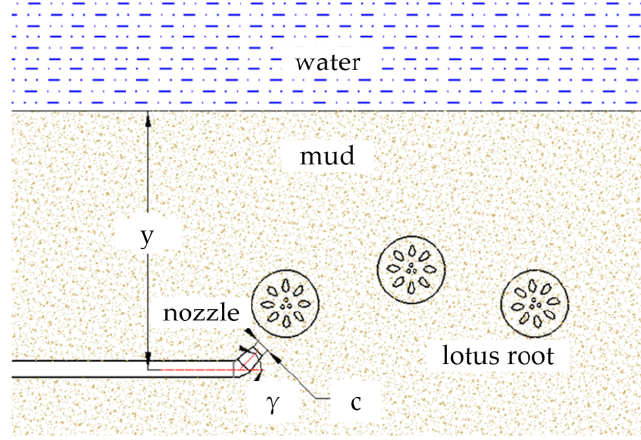
Figure 12. Schematic diagram of lotus root bottom flushing.